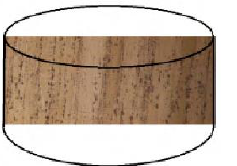
Figure 8. Comparison between experimental curve and fitting curve under different conditions. ( a ) 323.15 K, 3000 S − 1 . ( b ) 373.15 K, 3000 S − 1 . ( c ) 473.15 K, 1000 S − 1 . ( d ) 473.15 K, 3000 S − 1 .